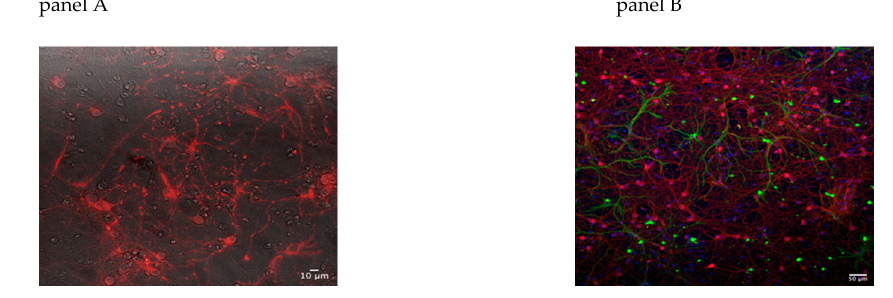
Figure 2. TMRM staining and immunofluorescence of mixed hippocampal mouse cultures. Panel ( A ), 15 div WT neuronal culture loaded with potentiometric dye TMRM 10 nM, imaged with the Nikon Eclipse T i inverted fluorescence microscope, 40 × magnification; fluorescence image super- imposed on the bright field image used to select neurons. Panel ( B ), representative image of 15 div neuronal culture; paraformaldehyde fixed cells were stained with: 1:100 anti-neurofilament 200 (NF 200, Merck-Sigma # N5389) labeling neurons, red; and with 1:100 anti glial fibrillary acidic protein (GFAP, Dako # 20334) labeling glial cells, green, and counterstained with Hoechst 100 µ g/mL, blue, to mark all nuclei. Images were collected with a Leica DMI 6000 inverted microscope, equipped with ORCA FLASH 4.0 camera (Hamamatsu), magnification 20 × . Analysis of images and composition of panels performed with the software